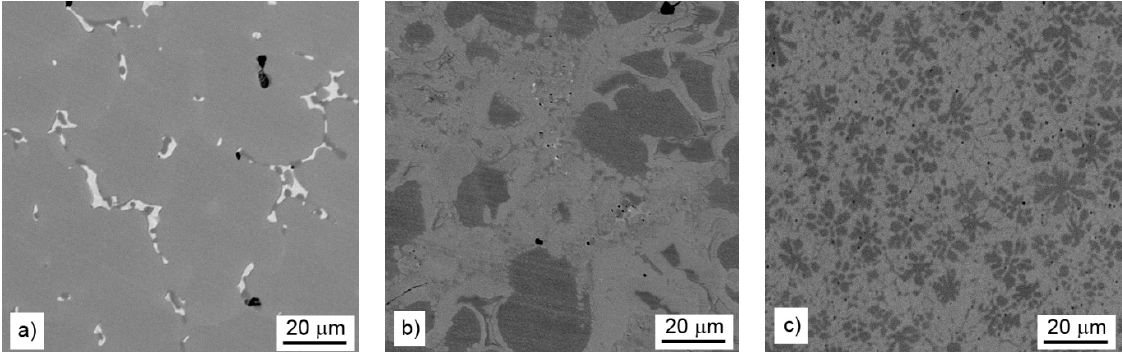
Figure 1. Microstructure of aluminothermically prepared samples ( a ) with stoichiometric amount of aluminum, ( b ) with 10% of aluminum excess, and ( c ) with 20% of aluminum excess.